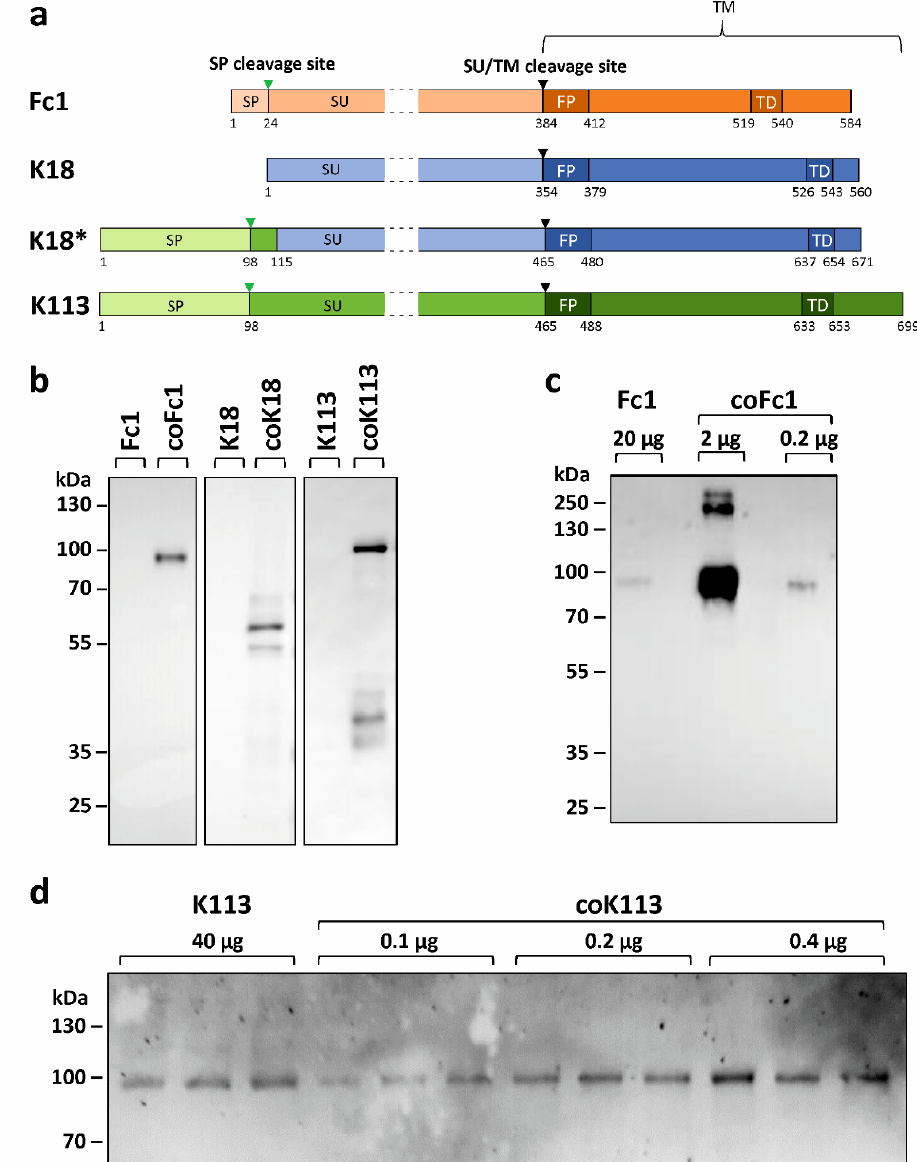
Figure 1. Expression and quantification of HERV envelope proteins in HEK293 cells. ( a ) Schematic representation of expressed HERV ENV. The pro-peptides are processed co- and post-translationally: The signal peptide (SP) is cleaved by signal peptidases (green triangle). The surface unit (SU) is separated from the transmembrane unit (TM) by furin-like proteases at a highly conserved consensus sequence (black triangle). The fusion peptide (FP) and the transmembrane domain (TD) are particularly hydrophobic regions within the TM. The chimeric K18* is composed of the signal peptide and another 17 amino acids of K113 plus amino acids 5 – 560 from K18. The numbers correspond to the amino acid positions. The SU is not shown to scale, but shortened. ( b ) Influence of codon optimization on protein biosynthesis of HERV ENV. Cell lysates were analyzed by Western blot 24 h after transient transfection of HEK293 cells with expression plasmids containing either the WT sequence or codon-optimized (co) sequences of the envelope proteins of HERV-Fc1, -K18, and -K113. Each lane was loaded with 20 µg total protein. ( c , d ) Representative Western blots used for densitometric quantification of expression increase caused by codon-optimization. The amount of total protein load is indicated for each lane. Representative loading controls are presented as Supplementary Figure S1. The following antibodies were used: Primary antibodies: anti-FLAG 1:1000 (Fc1), anti-HERV-K TM 1:1000 (K18, K113). Secondary antibodies: anti-rabbit IgG-HRP 1:2000, anti-mouse IgG-HRP 1:2000.